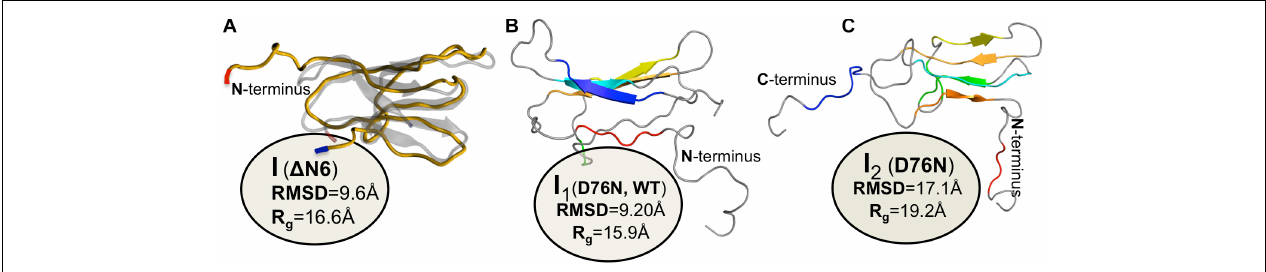
FIGURE 4 | Simulated monomers of β 2m. Three dimensional structure of three aggregation prone monomeric states predicted by a full atomistic G¯o model, used to explore the folding space of (cid:49) N6 (A) and D76N mutant (B,C) . The intermediate populated by (cid:49) N6 features an unstructured N terminal region (A) , while those populated by D76N display the C-terminus (B) , or both termini unstructured (C)